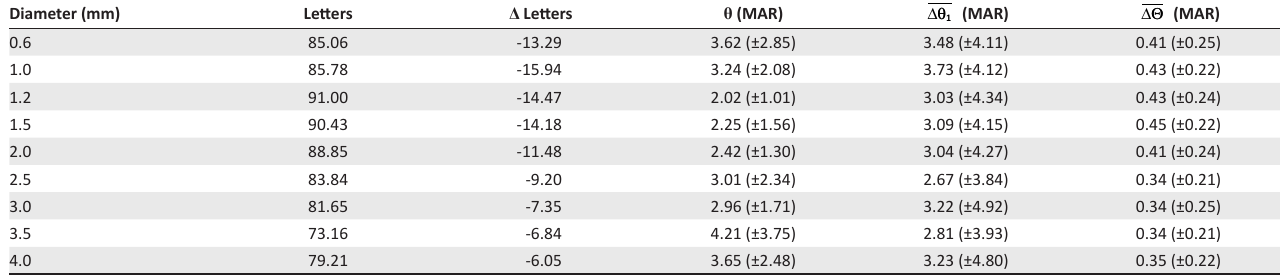
MAR, minimum angle of resolution.